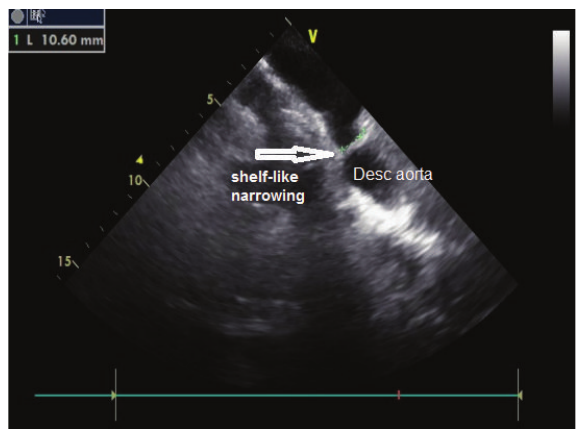
Figure 2: A Doppler echocardiographic gradient was 96 mmHg.